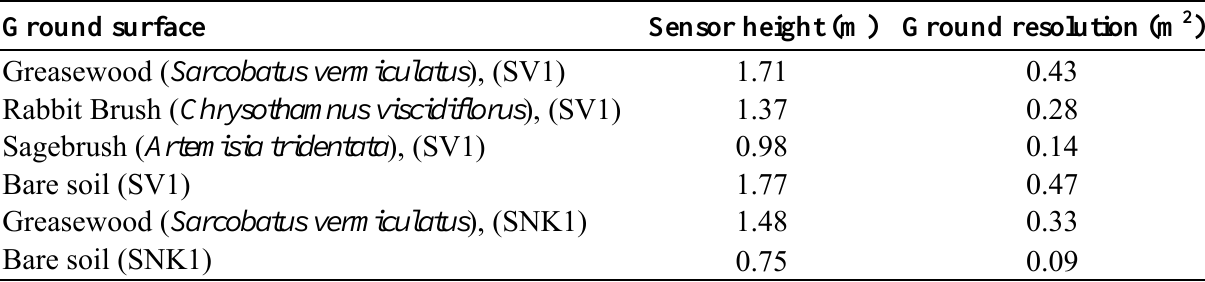
Table 1. NDVI sensor height and measured surface area of each ground